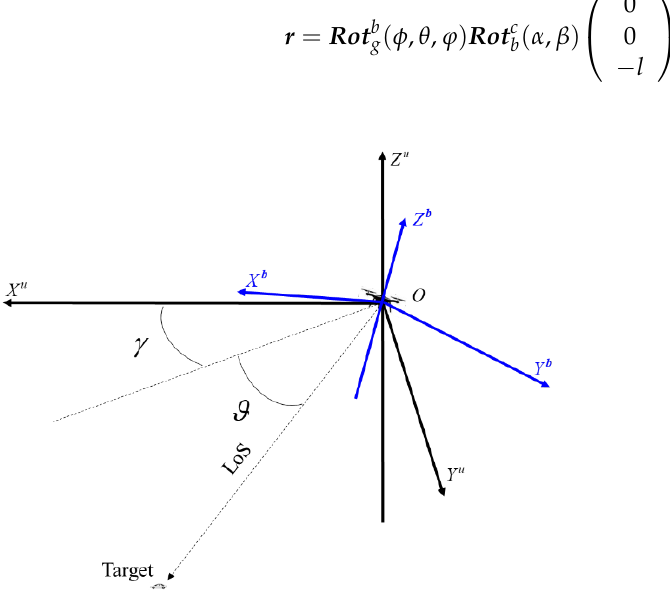
Figure 3. Schematic for 3D bearing-only target localization.